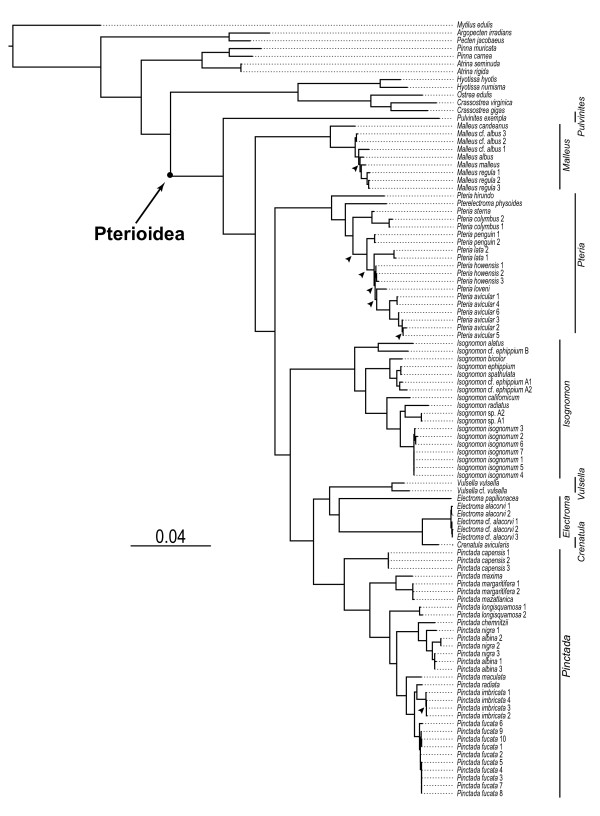
The maximum likelihood tree resulting from the analysis of the complete data set. The ML tree (-logLk = 30253.94) resulting from the combined analysis of the 18S, 28S, 16S, and H3 data. The scale bar indicates the number of substitutions per site. The nodes that disagree between the ML and MP topologies are indicated by arrows.